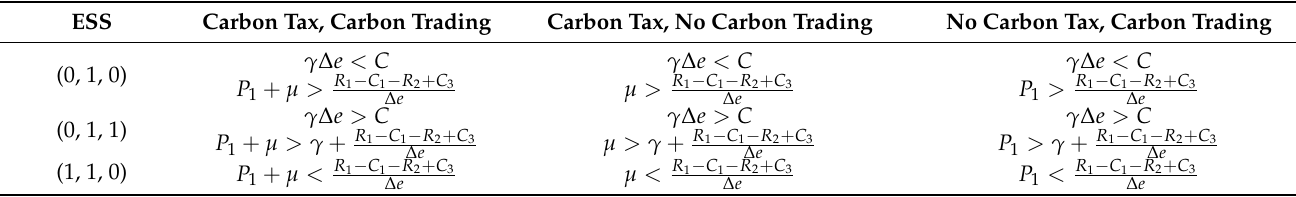
Table 5. Conditions that need to be met for the stabilization point.